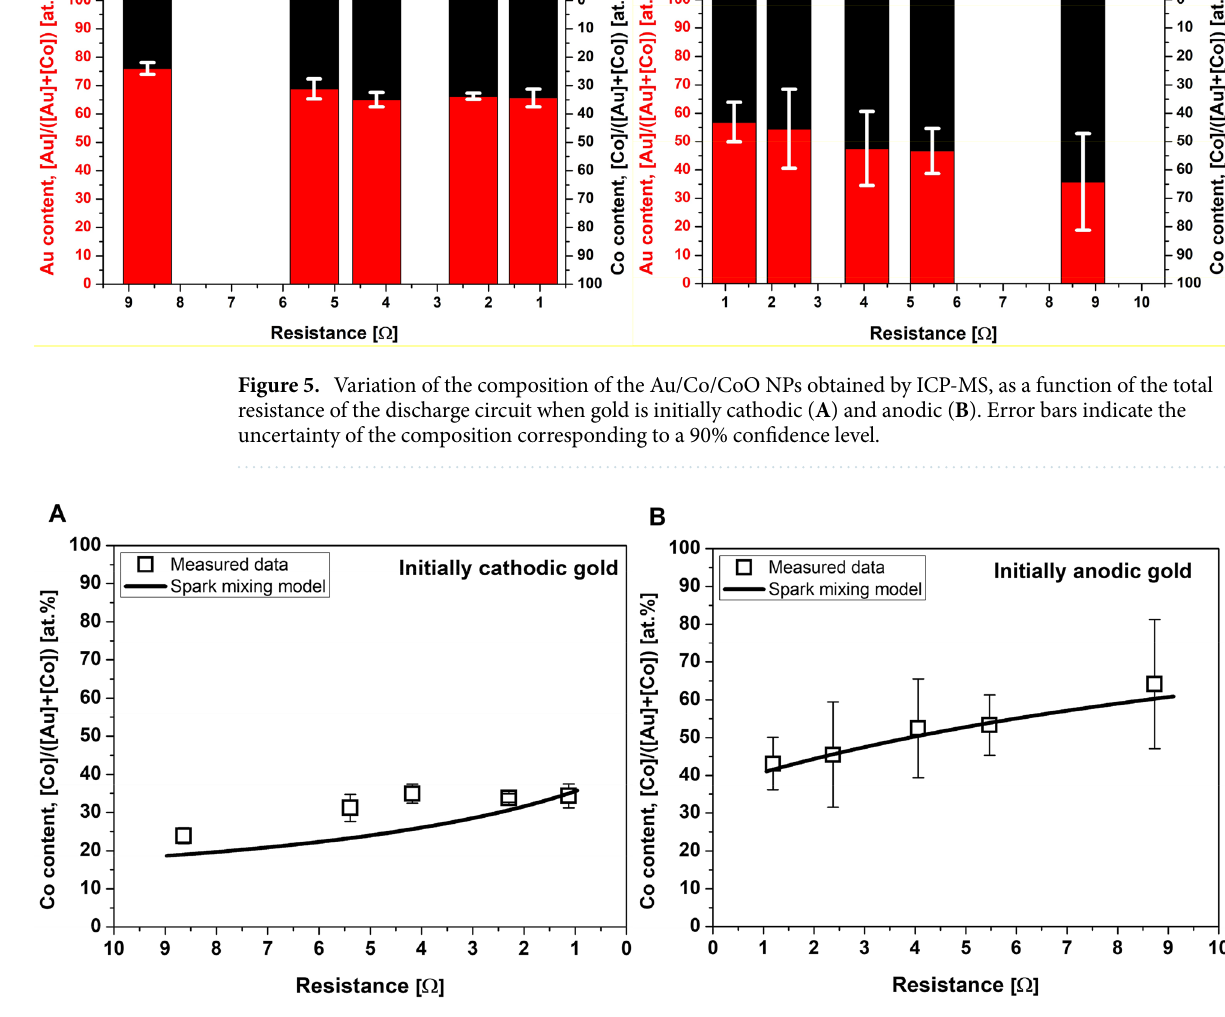
Figure 6. Comparison of the calculated (by using Eq. 1) and actual Co content of the generated Au/Co/CoO NPs with initially cathodic ( A ) and anodic ( B ) gold